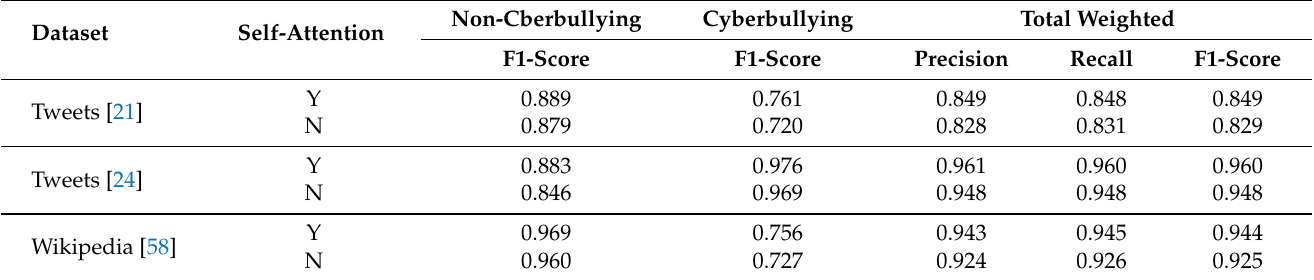
Table 7. Experiment Result for Proposed Method with/without Self-attention.